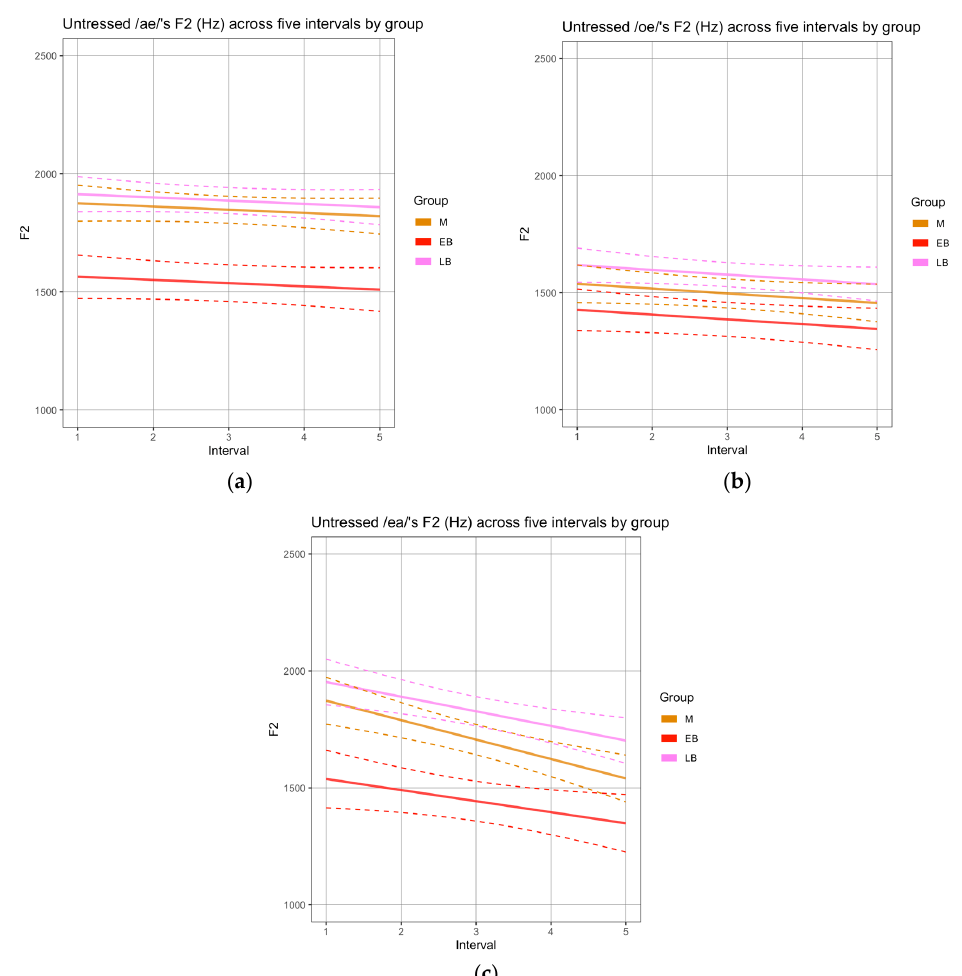
Figure 3. Smoothing Splines ANOVAs (SSANOVAs) for non-normalized (female) F2 trajectories across five intervals produced by each group of speakers (M, EB, LB) in the reading task. ( a ) Sequence /ae/; ( b ) sequence /oe/; ( c ) sequence /ea/.